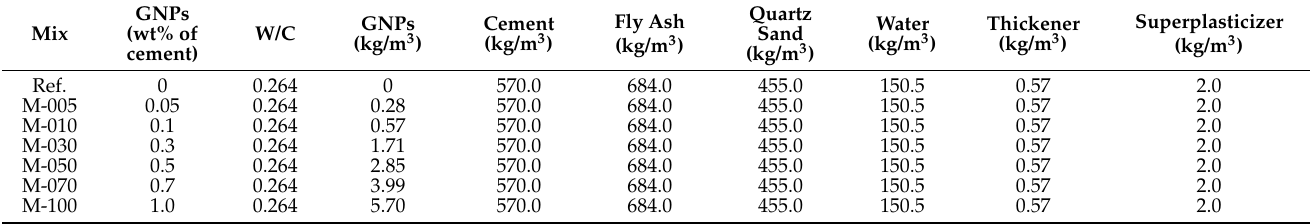
Table 4. Mix proportions of cement